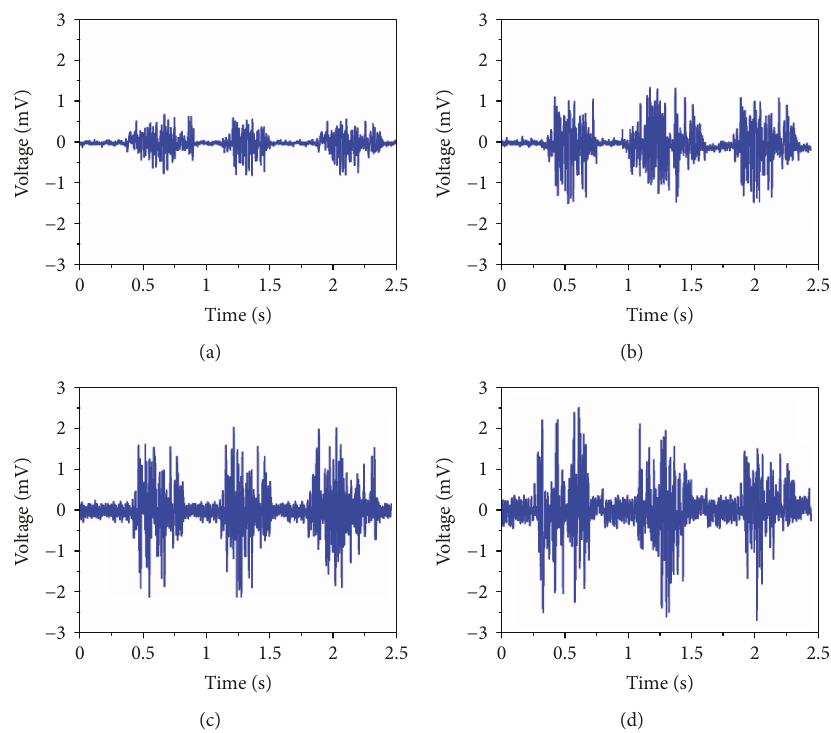
Figure 9: EMG signal from the capacitive electrode with di ff erent line widths. (a) w = 30 μ m; (b) w = 50 μ m; (c) w = 70 μ m; and (d) w = 90 μ